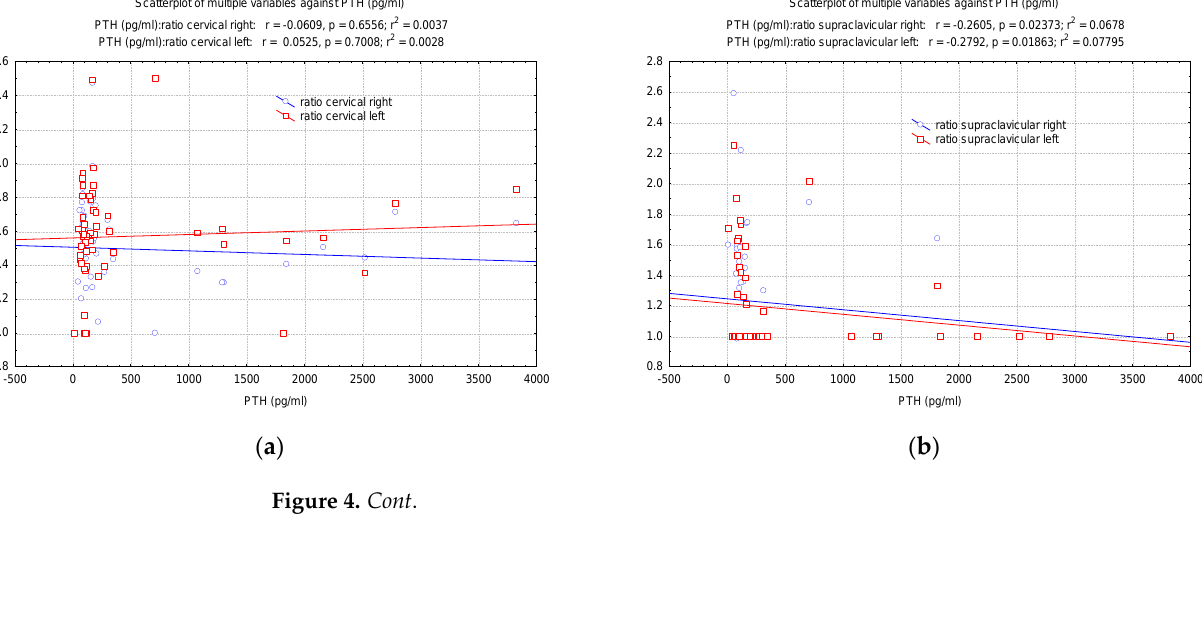
Figure 3. Pearson correlations between the demographic aspects ( a , b ) age, ( c , d ) body weight, ( e,f ) BMI and the values of (total counts/pixels) BAT /(total counts/pixels) non-BAT ratio. It was shown that an increase in PTH correlates with a decrease in the right and left supraclavicular BAT ratios ( r = −0 .260, p = 0.023 on the right; r = −0 .279, p = 0.018 on the left), however, these ratios rise with an increase in FT4 (r = 0.407, p = 0.012 on the right; r = 0.449, p = 0.005 on the left) (Figure 4). ratio cervical right ratio cervical left